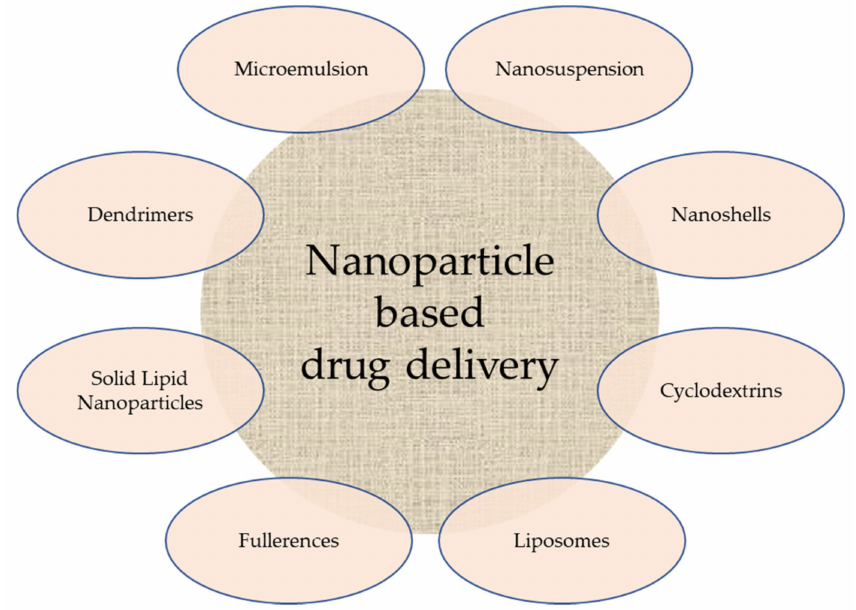
Figure 3. Various nanoparticulate drug delivery